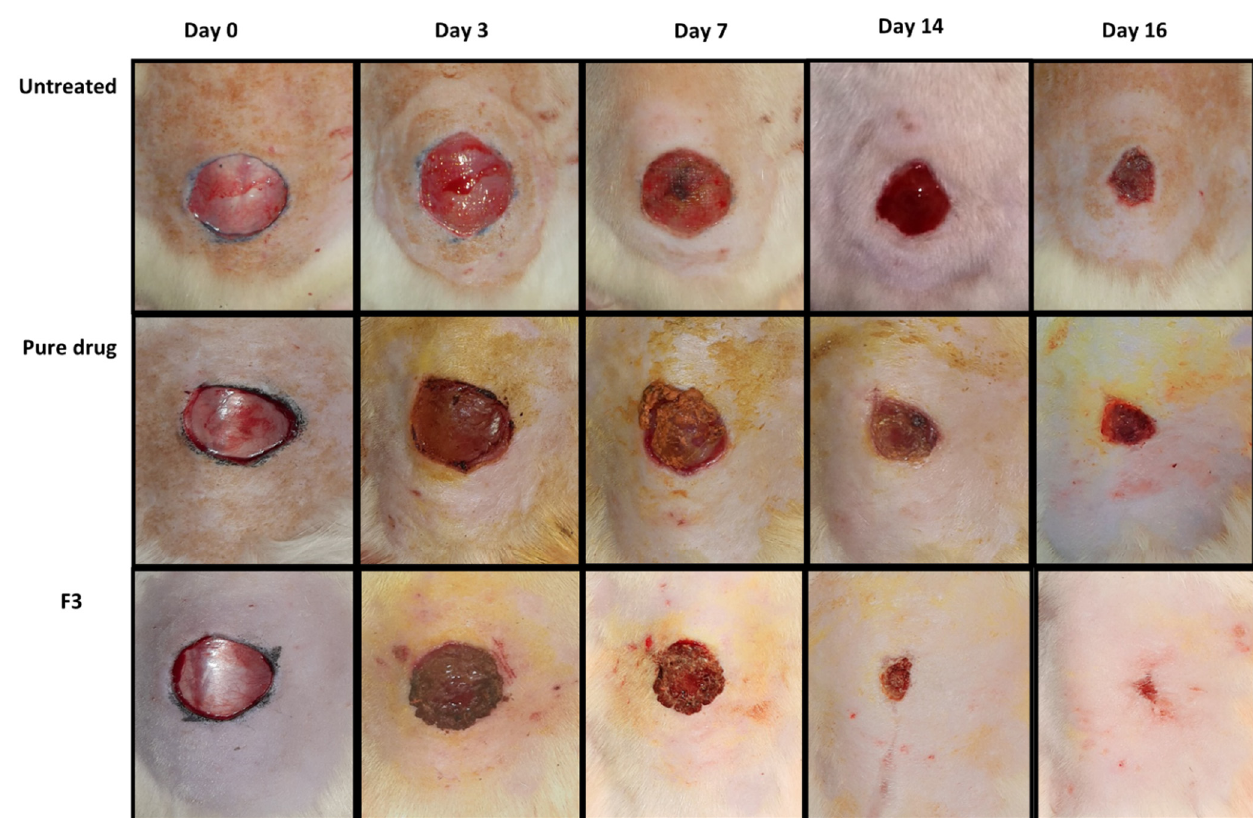
Figure 10. Photos of skin wounds upon treatment in the diabetic rats.